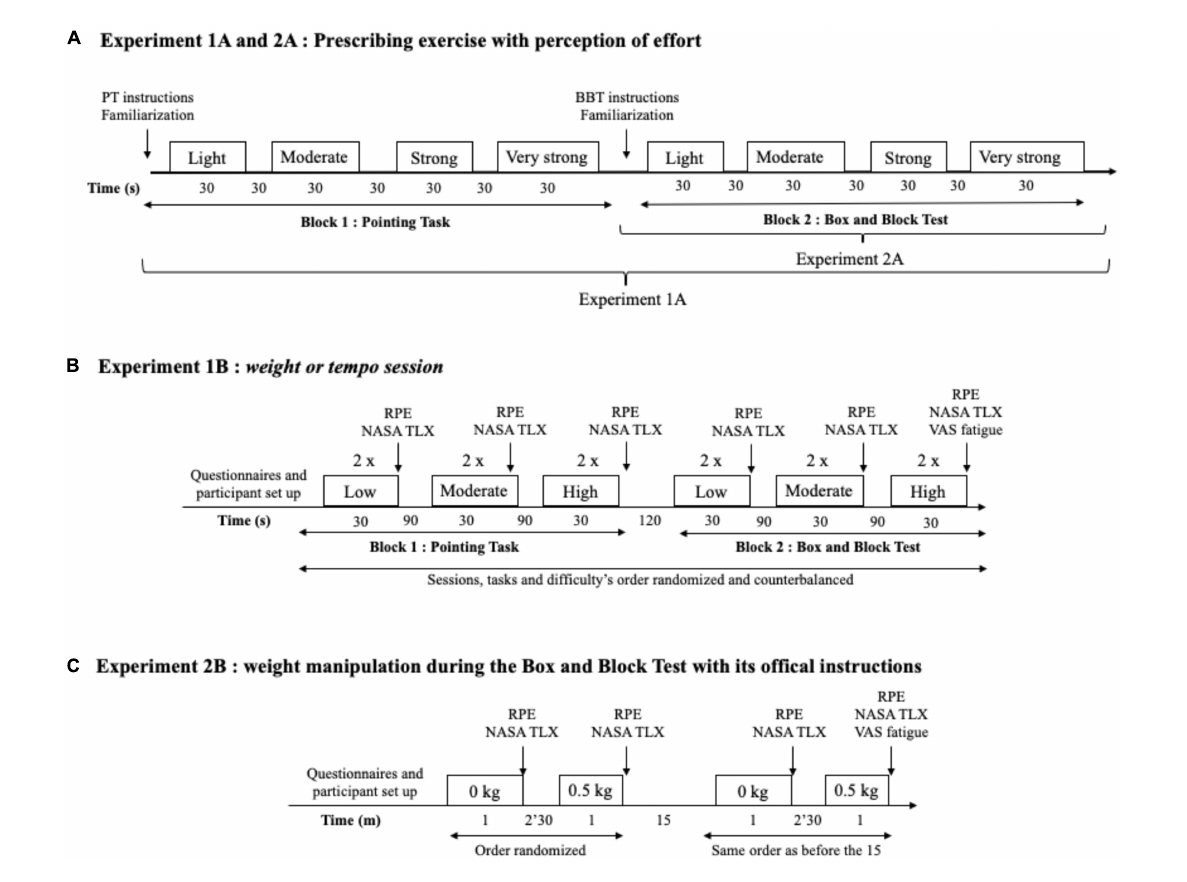
FIGURE2 (A) Experiments 1A and 2A overview: The procedures used to test the possibility to prescribe exercise using the perception of effort. The exercise was prescribed at four intensities of perceived effort via the CR100 scale: light (13/100), moderate (23/100), strong (50/100), and very strong (70/100). While both the pointing task (PT) and the box and block test (BBT) were performed in experiment 1A, only the BBT was performed in experiment 2A. (B) Experiment 1B overview. Set up consisted of the placement of the respiratory frequency belt, heart rate monitor, and EMG surface electrodes. Then, participants completed the indicated questionnaire or visual analog scale (VAS). Participants performed two repetitions per level of difficulty with 30 s of recovery in between. Rating of perceived effort (RPE) and subjective workload using NASA TLX scale were assessed in-between each level of difficulty. (C) Experiment 2B overview. Participants performed the box and block test for 60 with the absence (0 kg) or presence (0.5 kg) of additional weights. Set up consisted of the placement of the heart rate monitor and the EMG surface electrodes. Then, participants completed the indicated questionnaire or